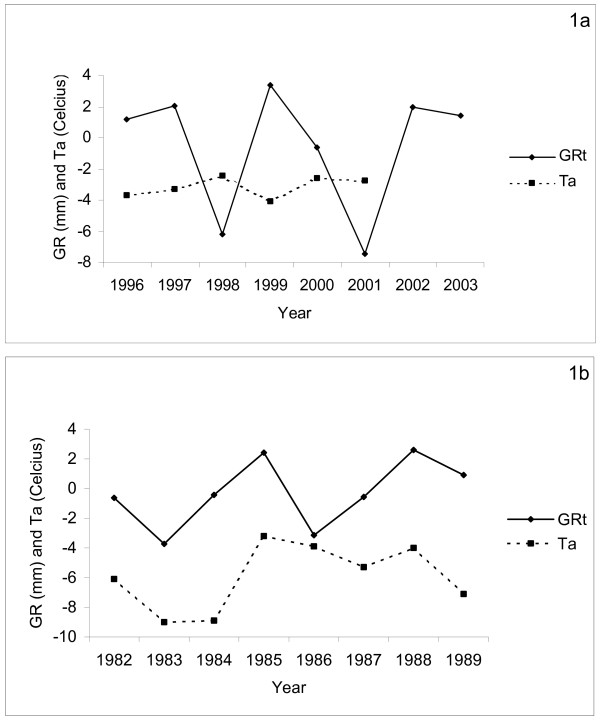
Growth rates obtained from otoliths of Arctic charr caught in Røde Elv 2004 and 1990 plotted against fluctuations in mean annual temperature. (a) Data from 2004 showing GRt (GRt = Growth rate residuals) in Arctic charr from Røde Elv plotted against fluctuations in Ta (Ta = Mean annual temperature). (b) Data from 1990 showing GRt in Arctic charr from Røde Elv plotted against fluctuations in Ta data from Aasiaat.